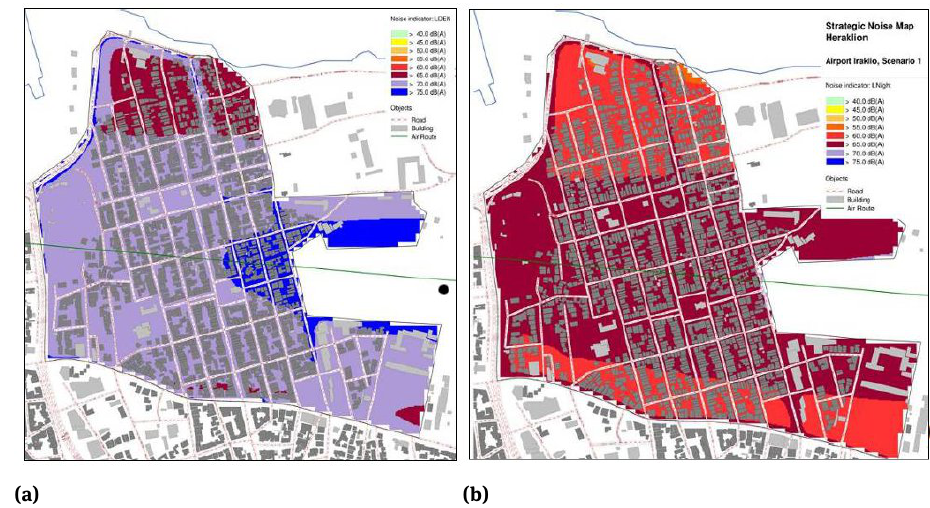
Fig. 9. Strategic Noise Maps 2012 for noise indices L den (a) and L night (b) for the Alikarnassos study area with airport operation. Table 4. Statistic coverage of Alikarnassos study area -